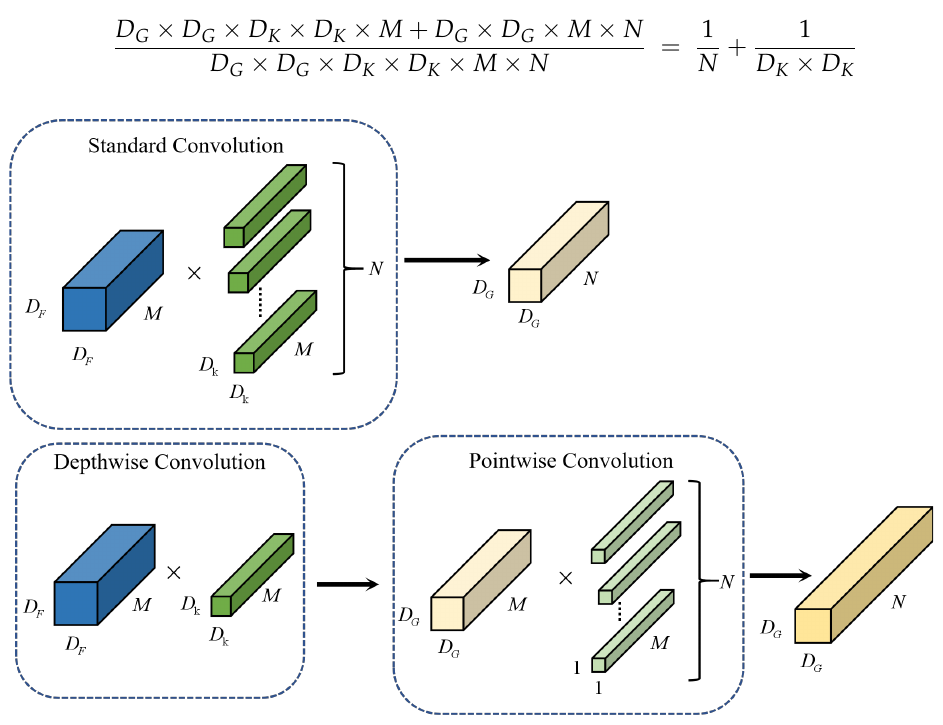
Figure 2. Standard Convolution process and Depthwise Separable Convolution process. D F , D k , D G , M and l are the dimensions, N is the number, and “×” is the multiplication formula.